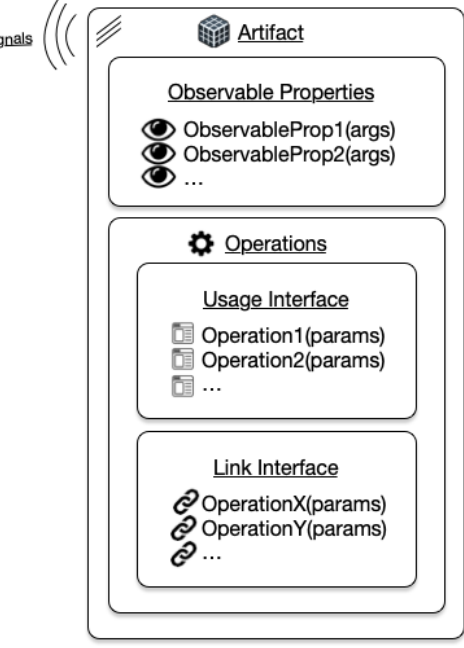
Figure 2. Artifact abstract model, as defined in